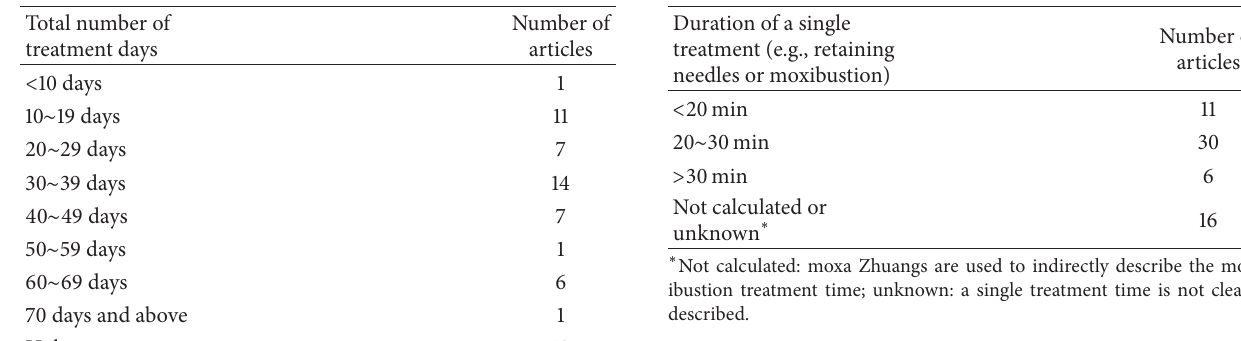
Table 6: Statistical results of total number of treatment days. Table 7: Statistical results of single treatment